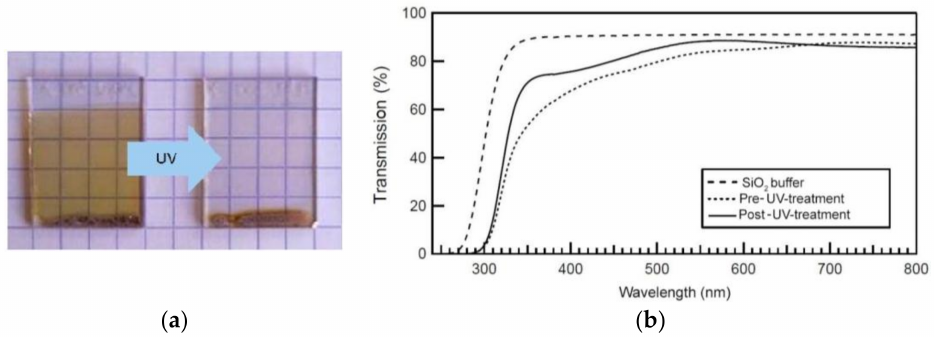
Figure 4. UV-treated Ti-EA coatings on a SiO 2 -PMMA substrate ( a ) and UV-VIS transmission spectra of the same coatings ( b ).